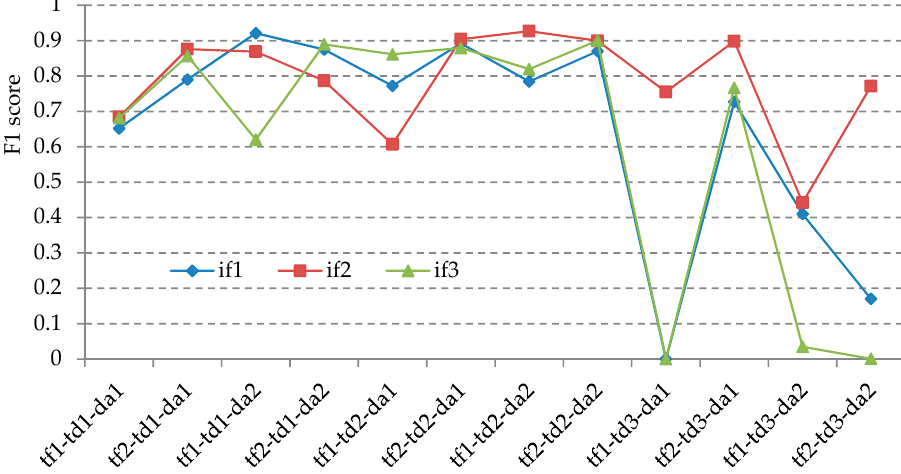
Figure 10. Average F1 scores of 10 test areas for 12 groups of models with di ff erent input features, as explained in Table